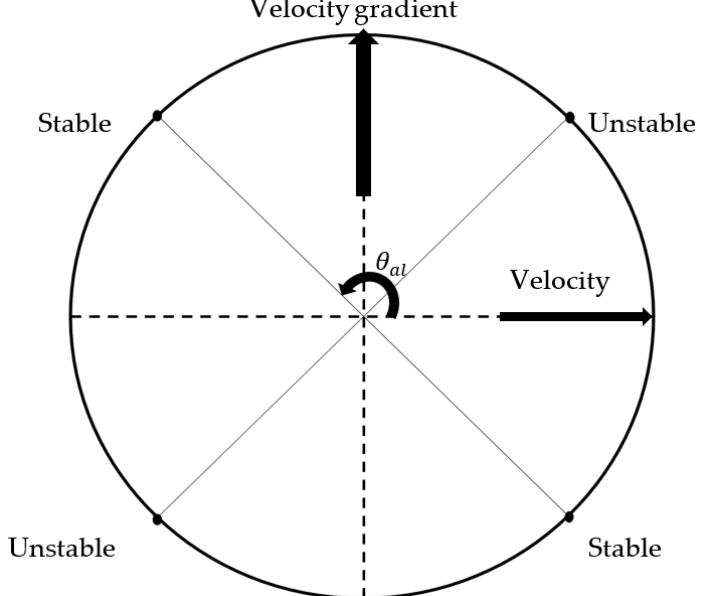
Figure 4. Schematic showing the stable and unstable alignment angles for nematic discotic liquid crystals based on the direction of the velocity and the velocity gradient.